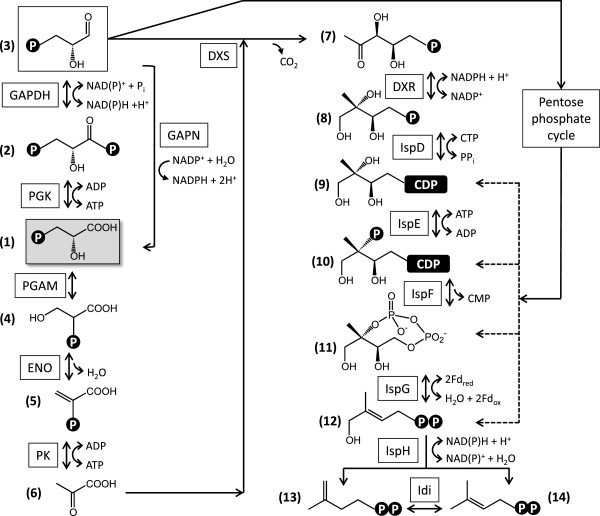
Reconstruction of the biosynthesis of terpenoid precursors in B. brauniiShowa. 1, 3-phospho-D-glycerate; 2, 3-phospho-D-glyceroyl phosphate; 3, D-glyceraldehyde 3-phosphate; 4, 2-phospho-D-glycerate; 5, phosphoenolpyruvate; 6, pyruvate; 7, 1-deoxy-D-xylulose 5-phosphate; 8, 2-C-methyl-D-erythritol 4-phosphate; 9, 4-diphosphocytidyl-2-C-methyl-D-erythritol; 10, 4-diphosphocytidyl-2-C-methyl-D-erythritol 2-phosphate; 11, 2-C-methyl-D-erythritol 2,4-cyclodiphosphate; 12, (E)-4-hydroxy-3-methylbut-2-en-1-yl diphosphate; 13, isopentenyl diphosphate; 14, dimethylallyl diphosphate. PGK, phosphoglycerate kinase; GAPDH, glyceraldehyde phosphate dehydrogenase; GAPN, NADP+-dependent glyceraldehyde 3-phosphate dehydrogenase; PGAM, phosphoglycerate mutase; ENO, phosphopyruvate hydratase; PK, pyruvate kinase; DXS, 1-deoxy-D-xylulose 5-phosphate synthase; DXR, 1-deoxy-D-xylulose-5-phosphate reductoisomerase; IspD, 2-C-methyl-D-erythritol 4-phosphate cytidylyltransferase; IspE, 4-(cytidine 5’-diphospho)-2-C-methyl-D-erythritol kinase; IspF, 2-C-methyl-D-erythritol 2,4-cyclodiphosphate synthase; IspG, (E)-4-hydroxy-3-methylbut-2-enyl diphosphate synthase; IspH, 4-hydroxy-3-methylbut-2-enyl diphosphate reductase; Idi, isopentenyl-diphosphate Δ-isomerase. Fd, ferredoxin.